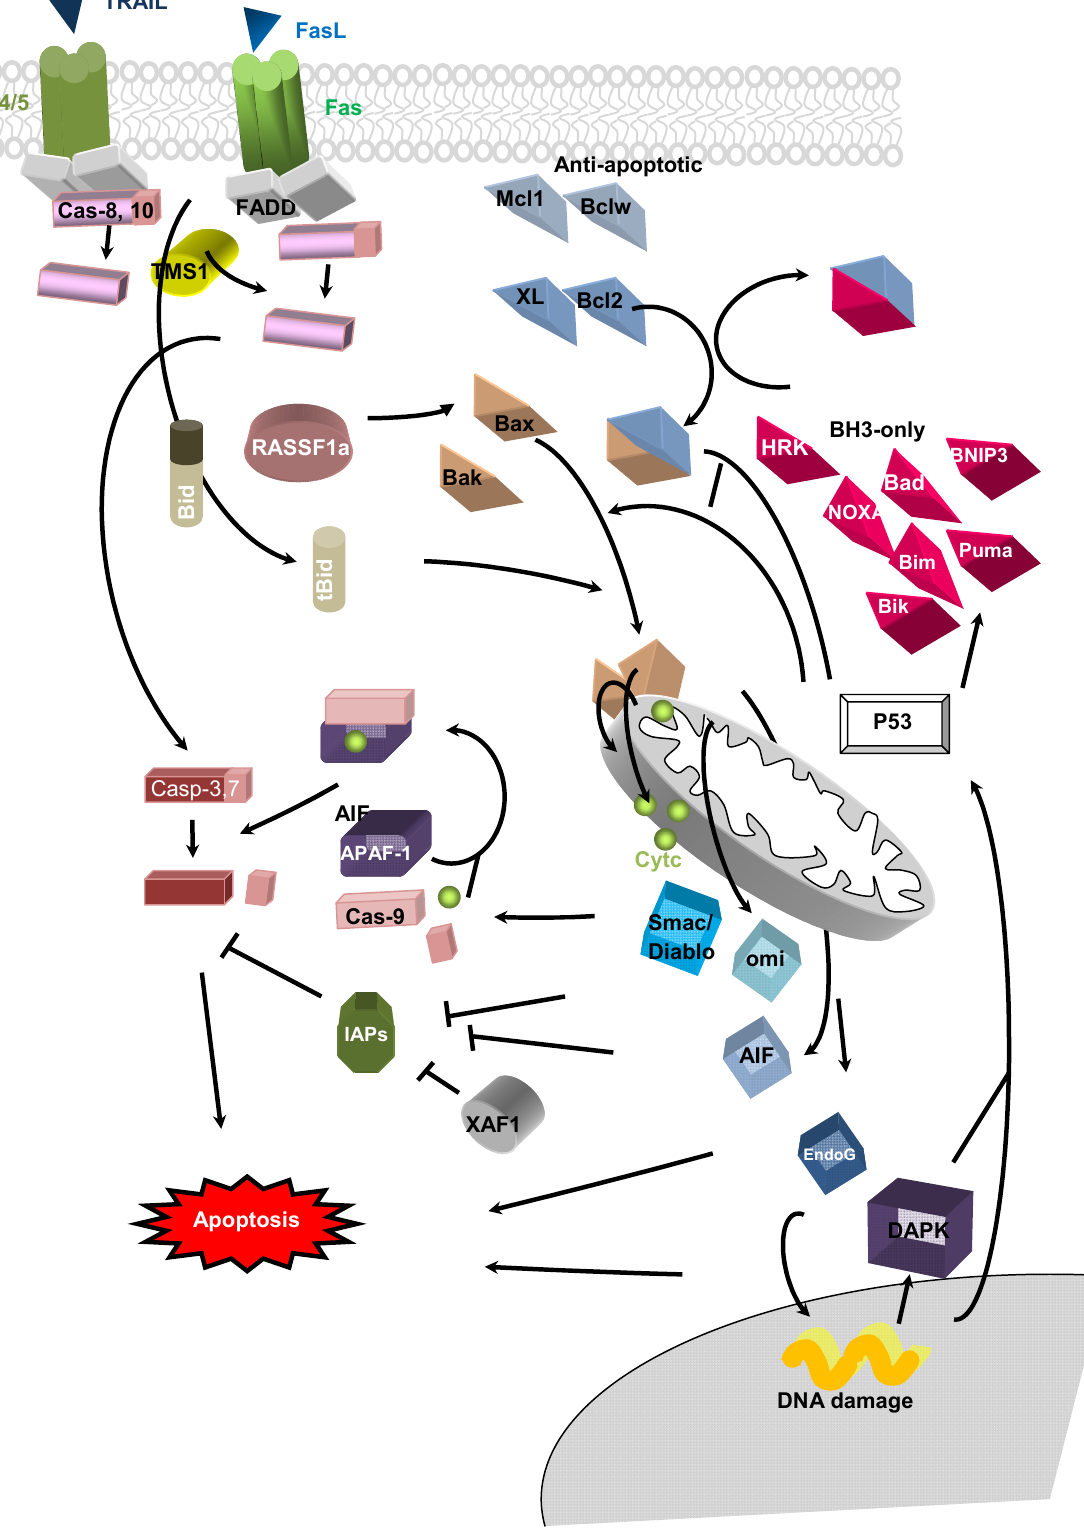
Figure 1. Mechanism of apoptosis. Activation of initiators caspase 8 and 10 are mediated in response to extrinsic stimuli and apoptosis signaling is controlled by anti- and pro-apoptotic protein